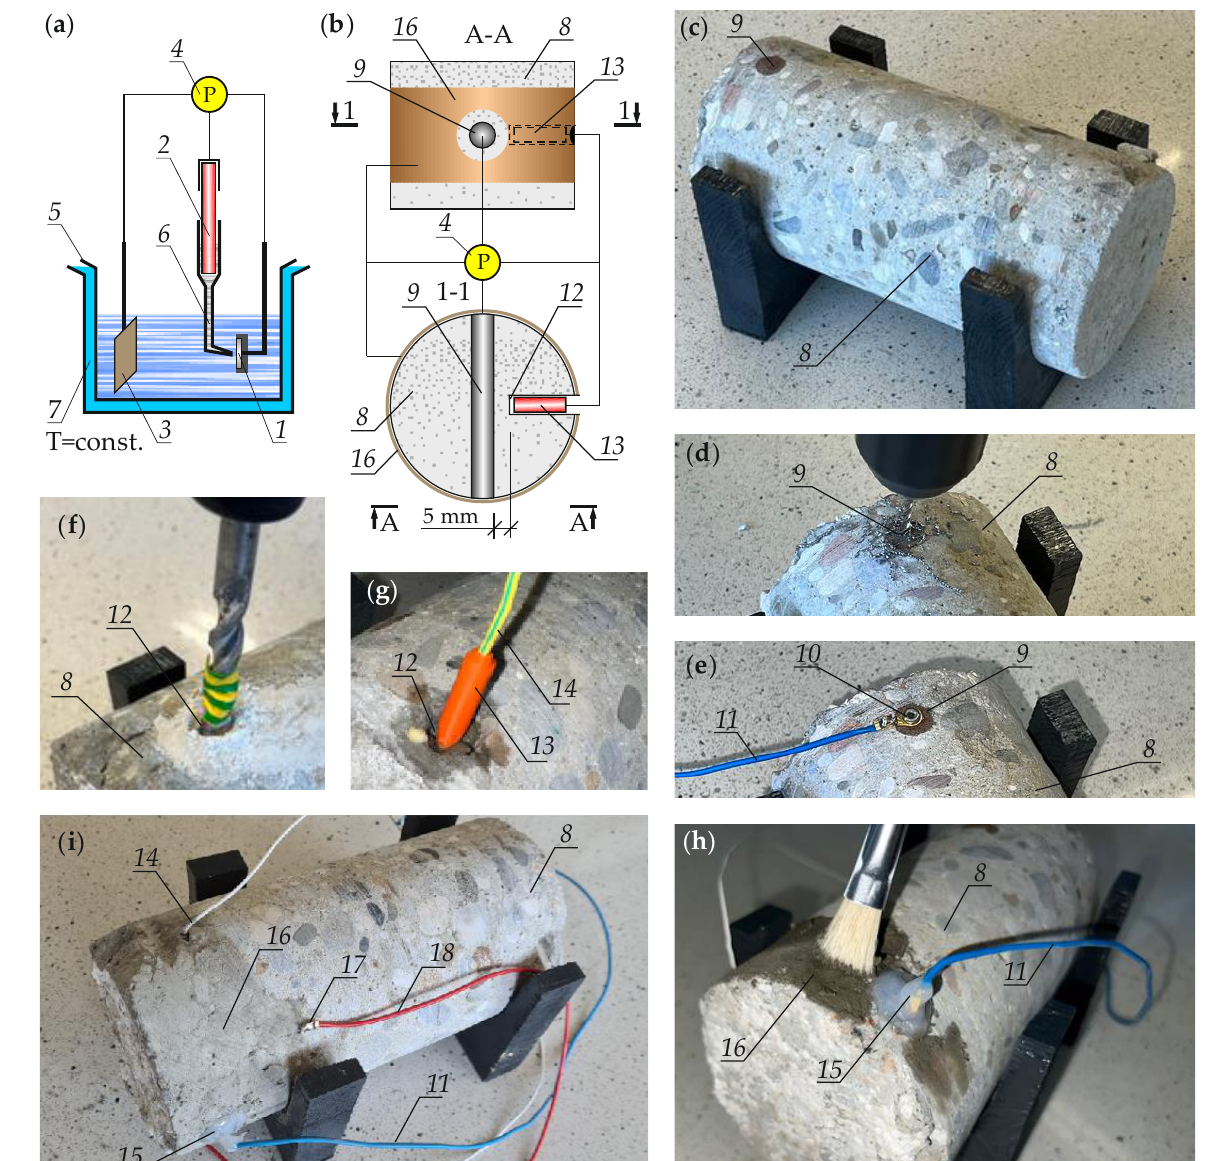
Figure 2. The three-electrode system used in the polarization tests: ( a ) the electrochemical cell used in the laboratory; ( b ) the system formed on the drilled core with a rebar fragment; ( c ) core drilled from the structure; ( d ) drilling an opening in the rebar to connect the conductor; ( e ) connecting the conductor to the rebar using a plug; ( f ) drilling an opening in concrete for the reference electrode; ( g ) the reference electrode before its placing in the opening; ( h ) application of conductive coating which is used as the auxiliary electrode; and ( i ) the ready specimen after toluene evaporation and